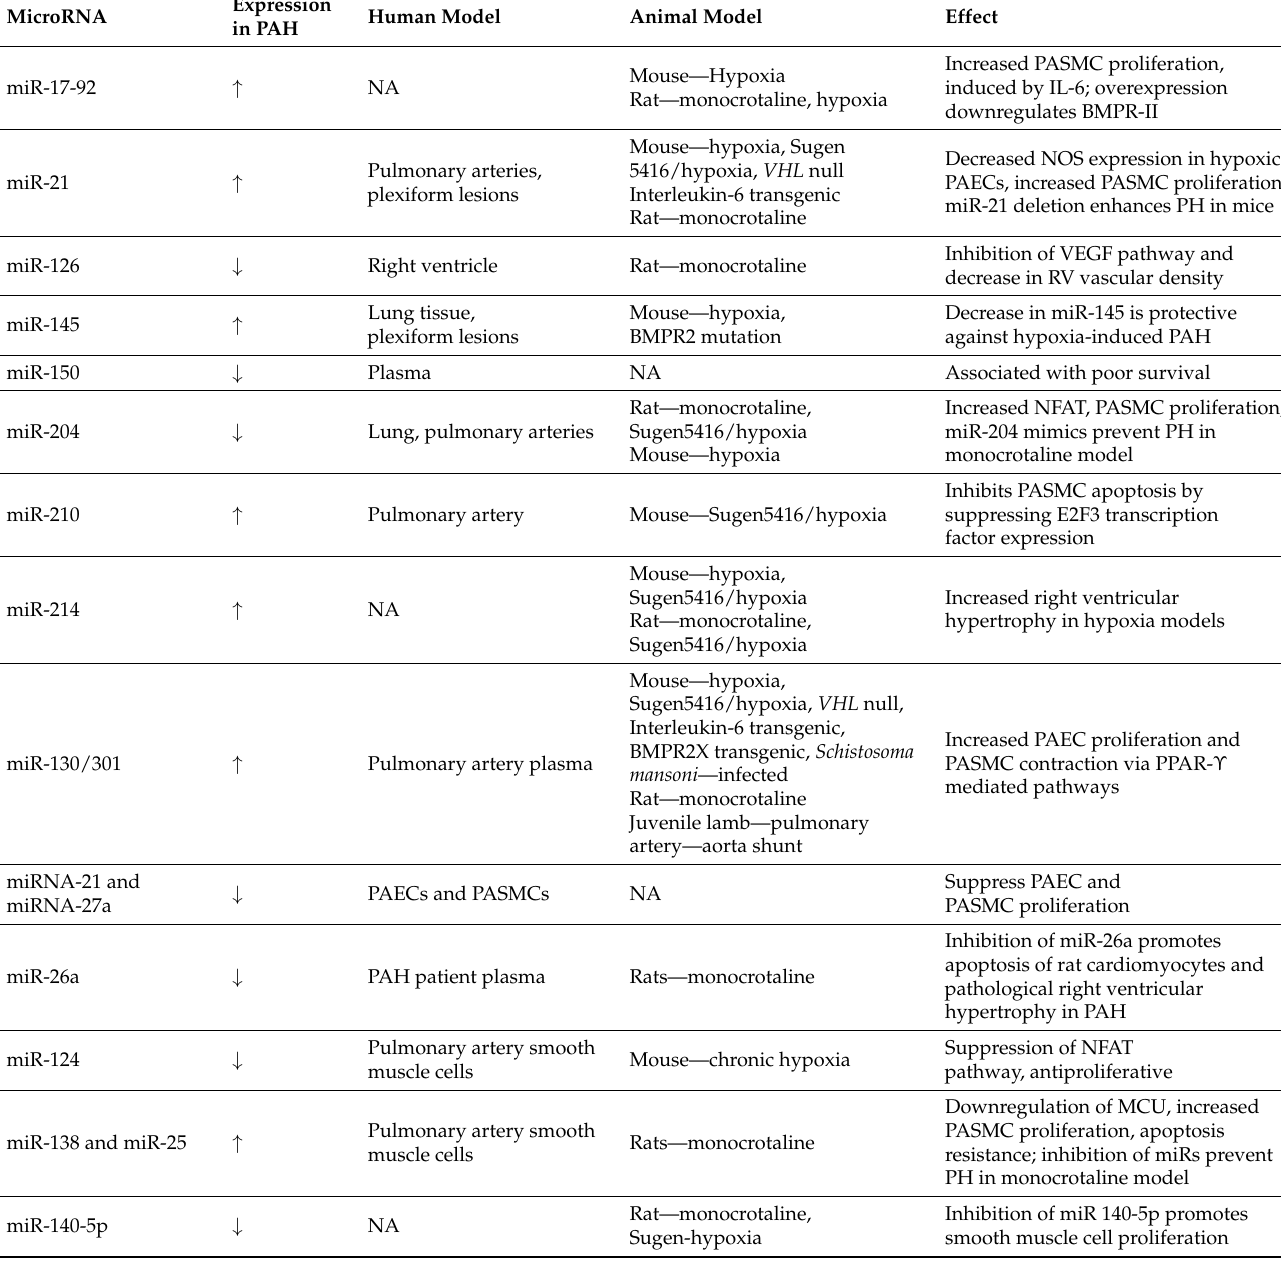
Table 3. Micro RNAs involved in pulmonary artery hypertension pathogenesis. miR: micro RNA, BMPR-II- type II: bone morphogenetic protein receptor; MCT: monocrotaline; NOS: nitric